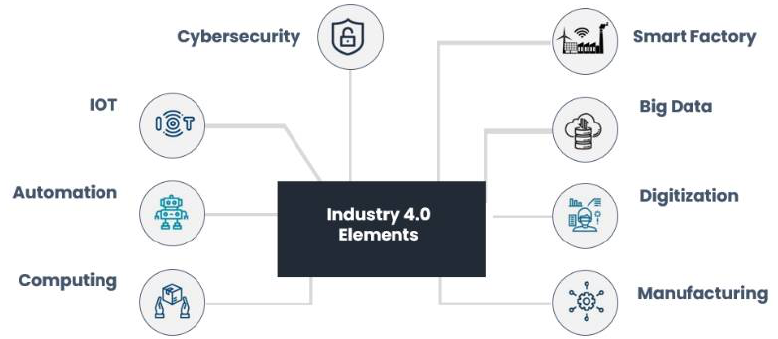
Figure 2. Components of Industry 4.0 technologies in the context of intelligent